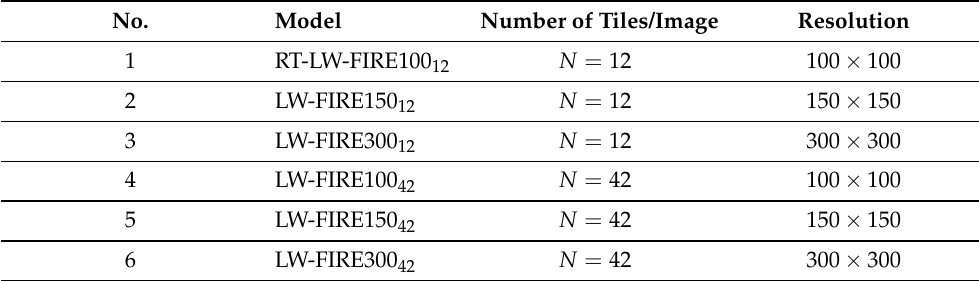
Table 4. Six proposed models based on different image tessellation schemes and three different sub-image